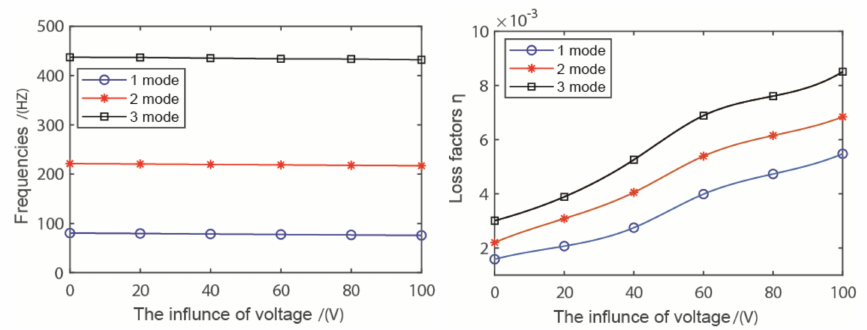
Figure 14. The influence of the voltage for the piezoelectric confinement